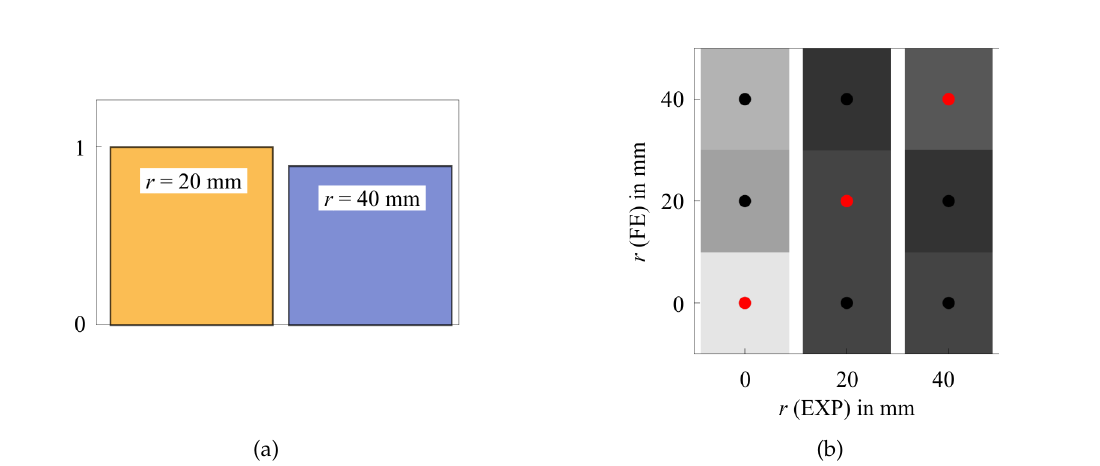
Figure 7. ( a ) Normalized MAPD damage metric indicators for 20-mm sandwich plates with different debonding sizes and frequency spectra Re( Z ). ( b ) Comparison of MAPD damage metric indicators of sandwich plates with different debonding sizes r calculated for every combination of numerical (FE) and experimental (EXP) results for frequency spectra Re( Z )